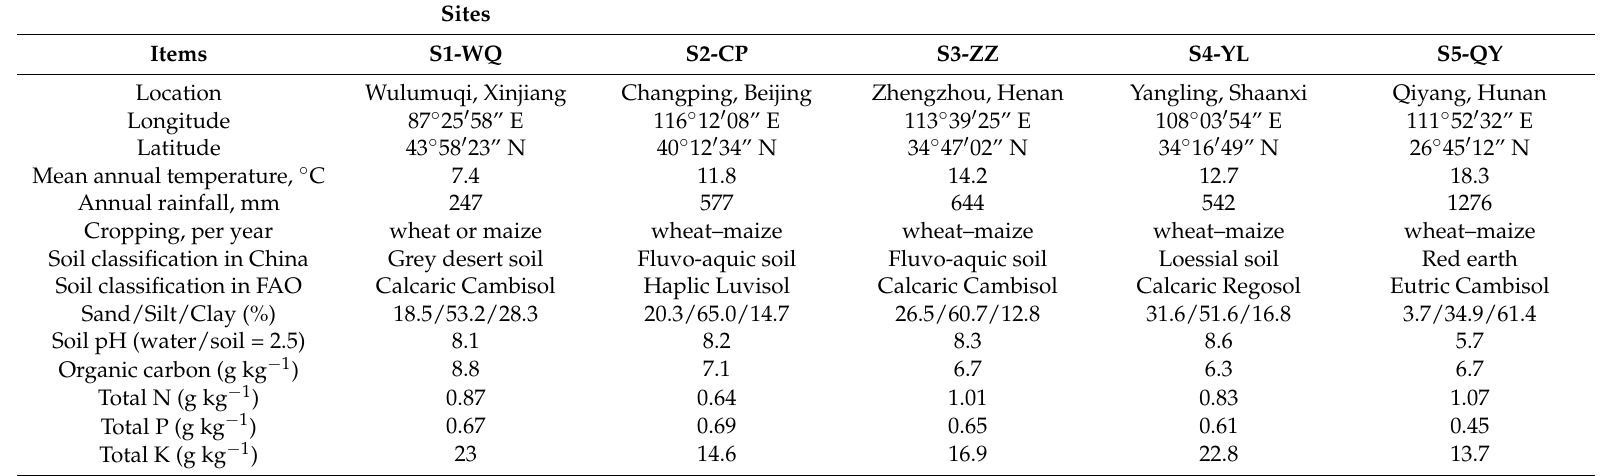
Table 1. The experiment sites and initial